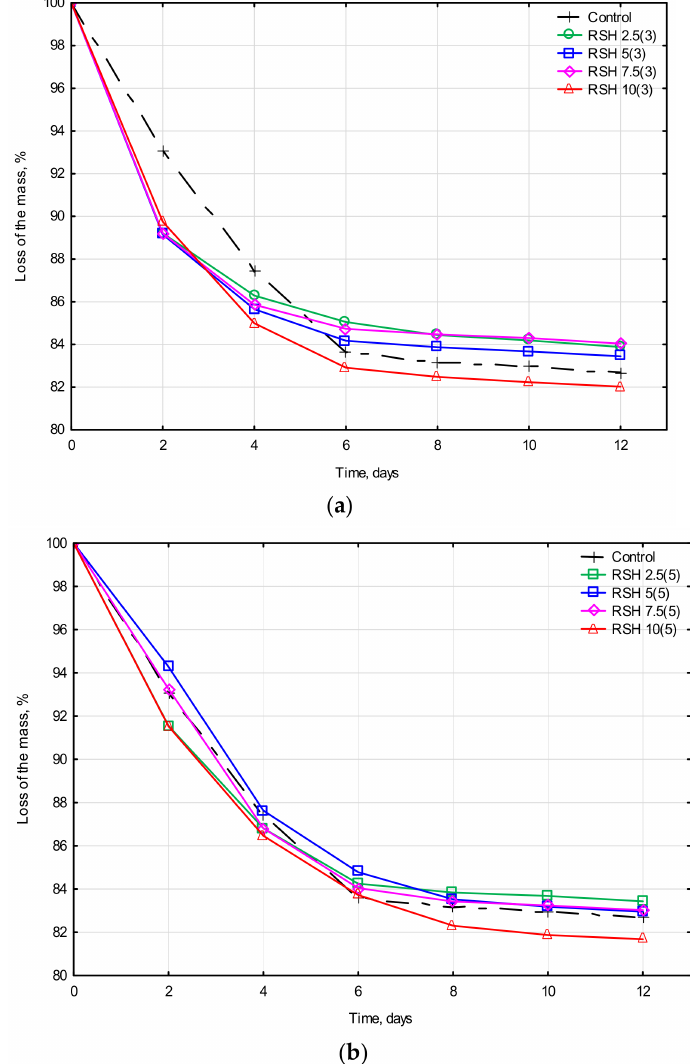
Figure 6. Drying kinetics of stabilized clay composites: ( a ) RSH heat-treated for 3 h and ( b ) RSH heat-treated for 5